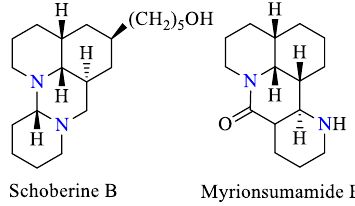
Figure 2. Myrioneuron type alkaloids.